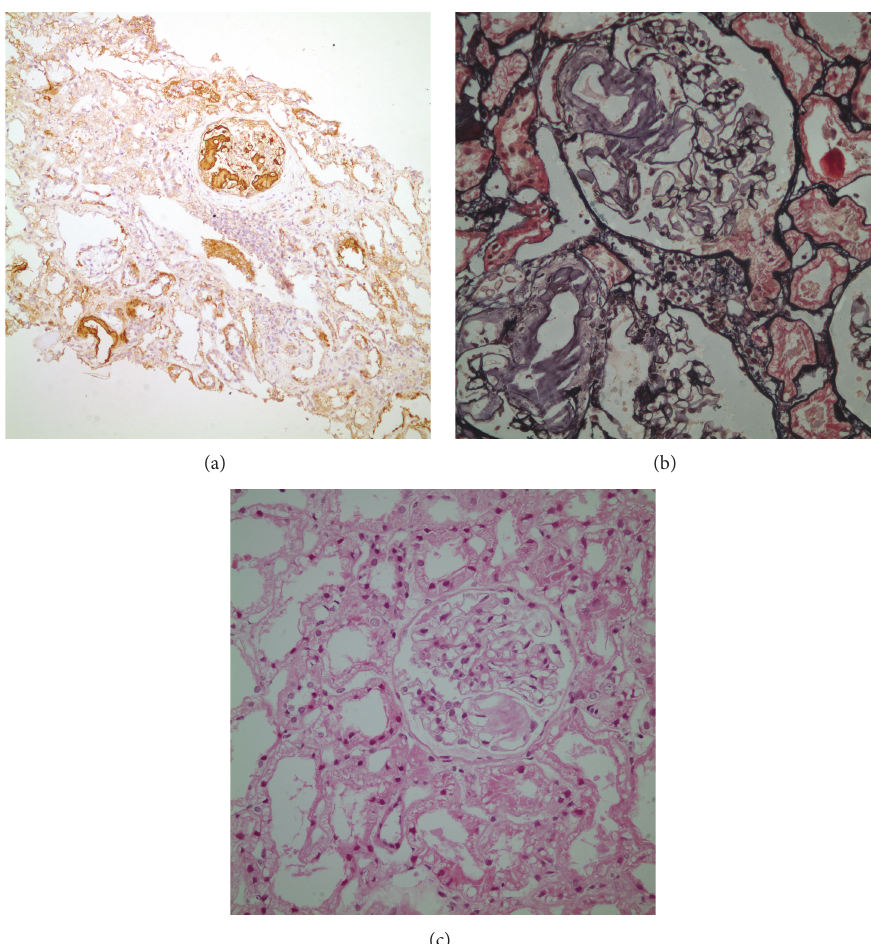
Figure 2: Immunohistochemical reactivity of deposited material with anti-amyloid A protein, note staining of glomeruli and vascular walls (a). Negative staining of deposited material (consistent with amyloid) silver stain (b). Focal mesangial widening due to deposition of amorphous acellular eosinophilic material consistent with amyloid. Note deposition of amyloid along the hilar arterioles